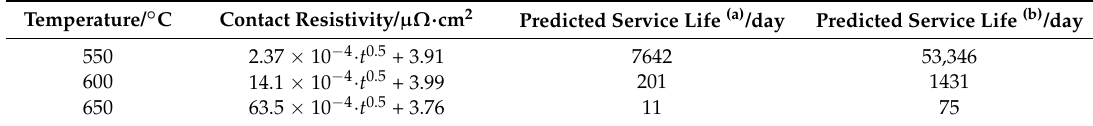
Table 2. Fitting results of the relationship between the contact resistivity and the aging time, and predicted service life (The prediction is based on the assumption that a joint fails when the contact